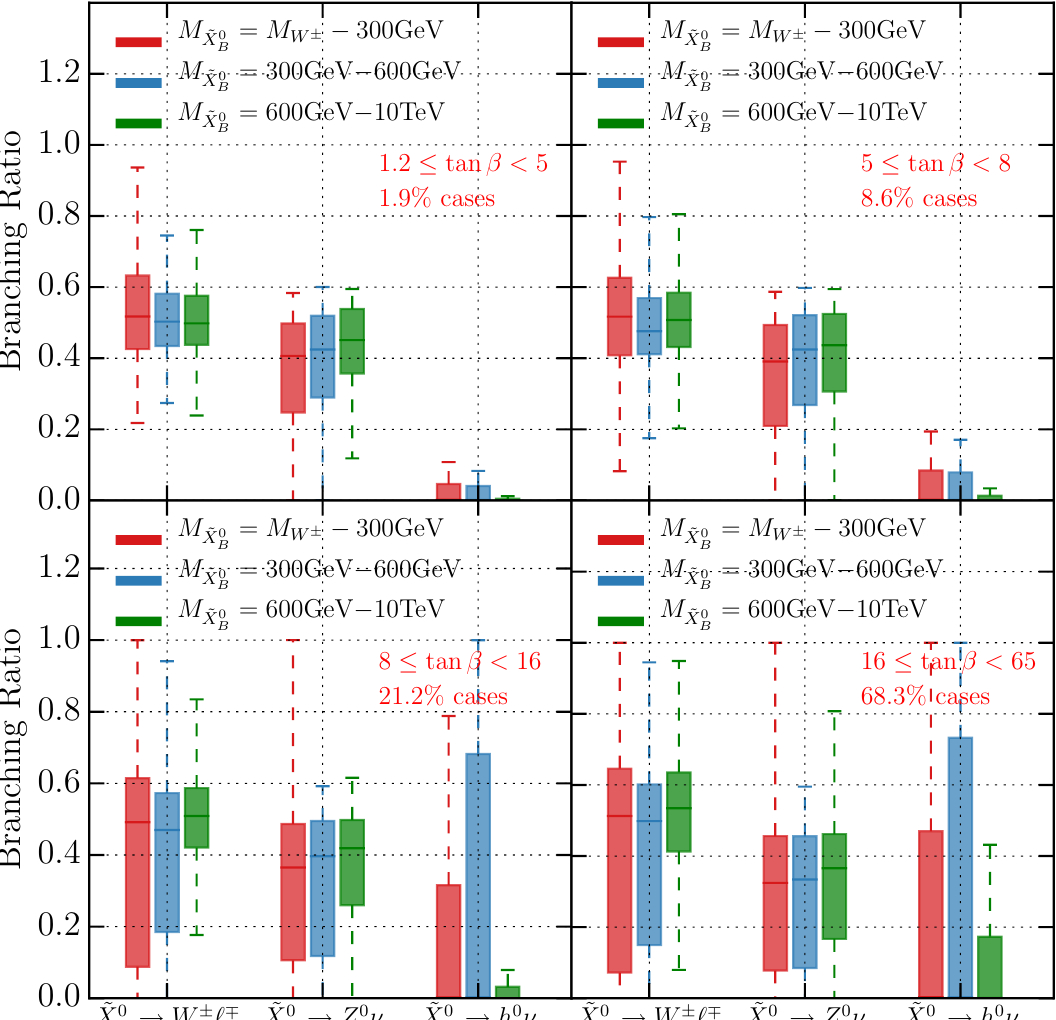
Figure 5. Branching ratios for the three possible decay channels of a Bino neutralino LSP with mass M ~ (cid:21) M divided over three mass bins and four tan (cid:12) regions. The colored horizontal W (cid:6) X 0 B lines inside the boxes indicate the median values of the branching fraction in each bin, the boxes indicate the interquartile range, while the dashed error bars show the range between the maximum and the minimum values of the branching fractions. The case percentage indicate what percentage of the physical mass spectra have tan (cid:12) values within the range indicated. We assumed a normal neutrino hierarchy, with (cid:18) 23 = 0 : 597. Note that the median values of the ~ X 0 approaches zero for all mass ranges and all values of tan (cid:12)